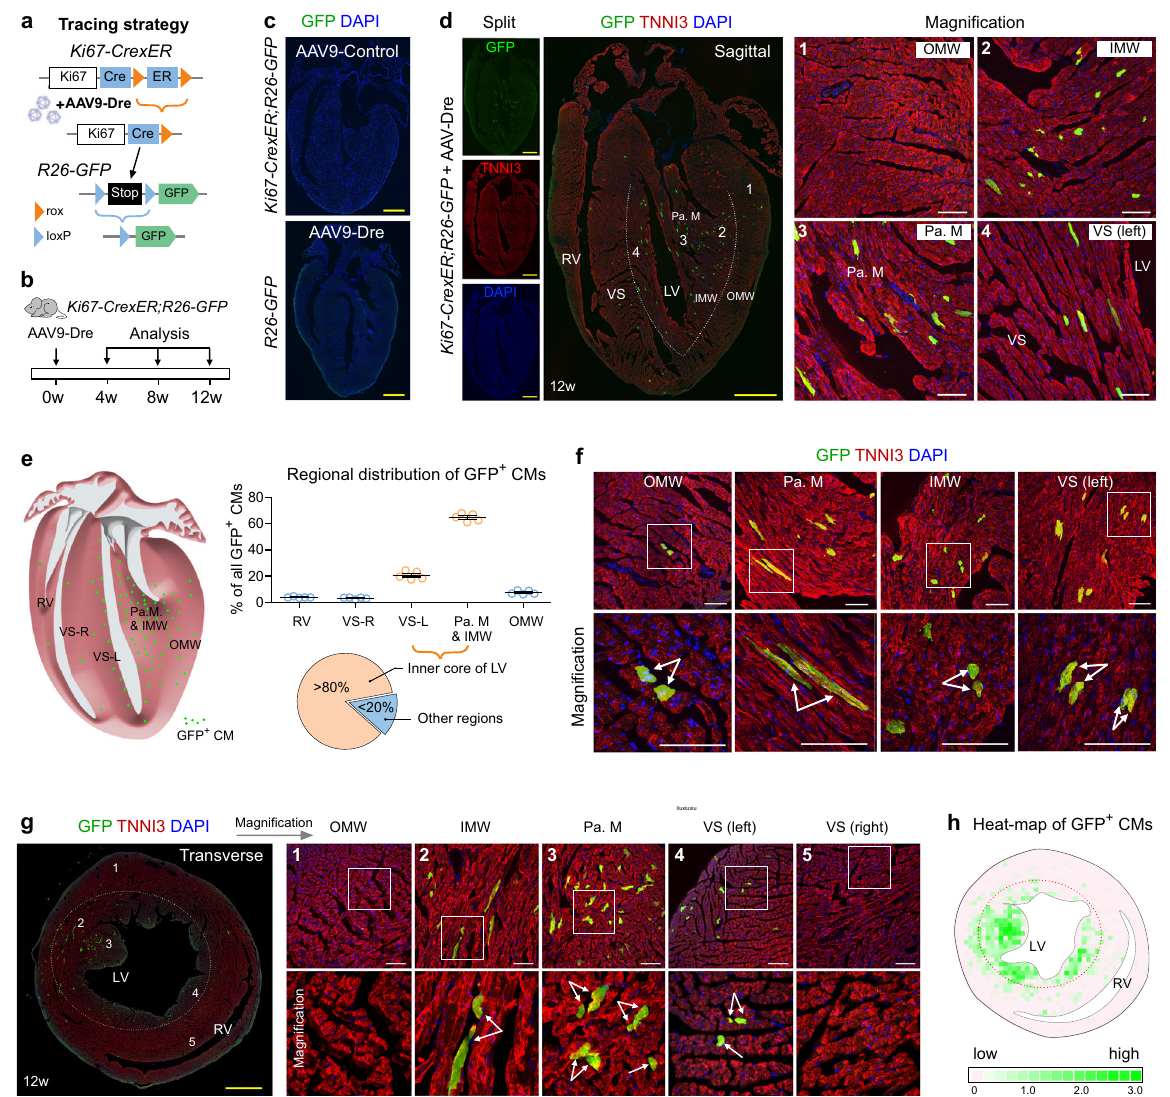
Fig. 2 Cardiomyocyte-speci fi c ProTracer identi fi es highly regional cardiomyocyte cell-cycle activity in adult hearts. a Schematic showing AAV9-Dre- induced tracing of cardiomyocyte cell-cycle activity. b Schematic illustrating the experimental design. c Immunostaining for GFP on heart sections prepared from Ki67-CrexER ; R26-GFP mice treated with AAV9-control or R26-GFP mice treated with AAV9-Dre. d Immunostaining for GFP and TNNI3 on heart sections collected from Ki67-CrexER ; R26-GFP mice treated with AAV9-Dre. Numbered regions (1,2,3,4) are magni fi ed on the right. OMW outer myocardial wall, IMW inner myocardial wall, Pa. M papillary muscle, VS ventricular septum, RV right ventricle, LV left ventricle. e Illustration of cycling CMs (GFP) in the adult heart in 12 weeks. Quanti fi cation of the distribution of GFP + CMs in different regions of the ventricles. Data are the mean ± s.e.m.; n = 5. f Representative images showing GFP + CMs (arrows) in different regions of hearts. g Immunostaining for GFP and TNNI3 in transverse heart sections. The dotted line demarcates the inner core region of the LV that harbors the majority of the GFP + cardiomyocytes in the ventricles. Numbered regions (1 – 5) are magni fi ed on the right. Arrows, GFP + cardiomyocytes. h Heat-map of GFP + cardiomyocytes (CM) in transverse heart sections. The green color intensity indicates the average number of GFP + CMs in each 0.0256 mm 2 square from fi ve heart sections. The red dotted line demarcates the inner core region of the LV. Scale bars, yellow, 1 mm; white, 100 µ m. Each image is representative of fi ve individual biological